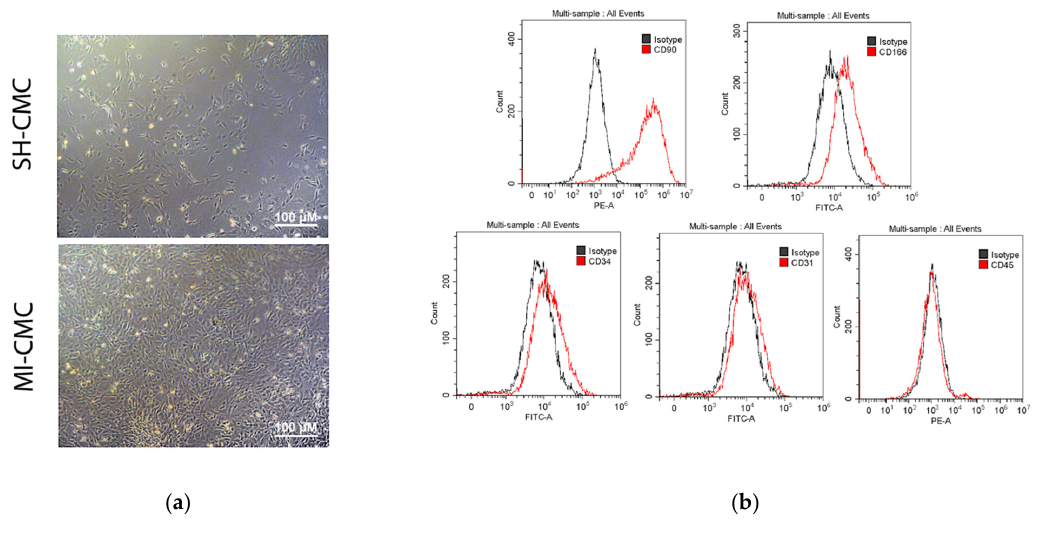
Figure 3. ( a ) Cardiac mesenchymal cells (CMCs) derived from healthy (SH-CMC) and postinfarct (MI-CMC) myocardium of rat during 5-day cultivation. CMCs were isolated 24 h after myocardial infarction. SH-CMC were obtained from rat hearts after sham operation. The primary cell culture of CMCs demonstrated the ability to form fibroblast colony-forming units (CFU-F) and had adhesion to a culture plastic. ( b ) Immunophenotyping of primary cultures of CMC using flow cytometry. The histograms show the expression levels of surface markers CD31, CD34, C45, CD90, and CD166 (red lines) concerning isotype (gray